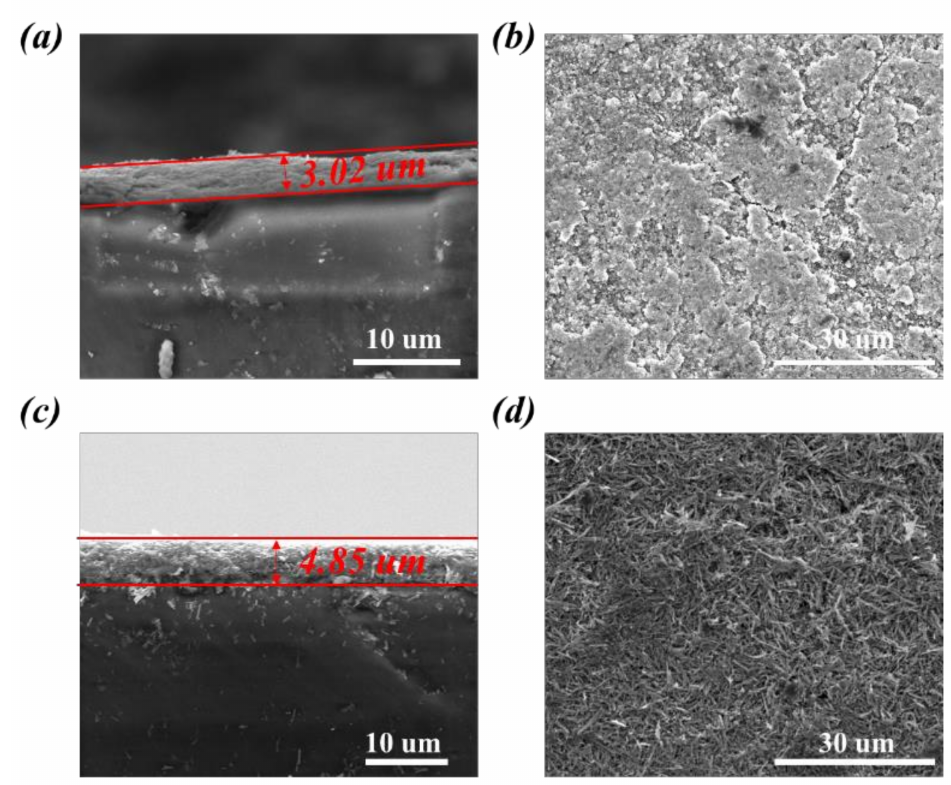
Figure 3. ( a , c ) SEM cross–sections and ( b , d ) SEM images of the IrO 2 and IrO 2 /N–TiO 2 catalyst layers,